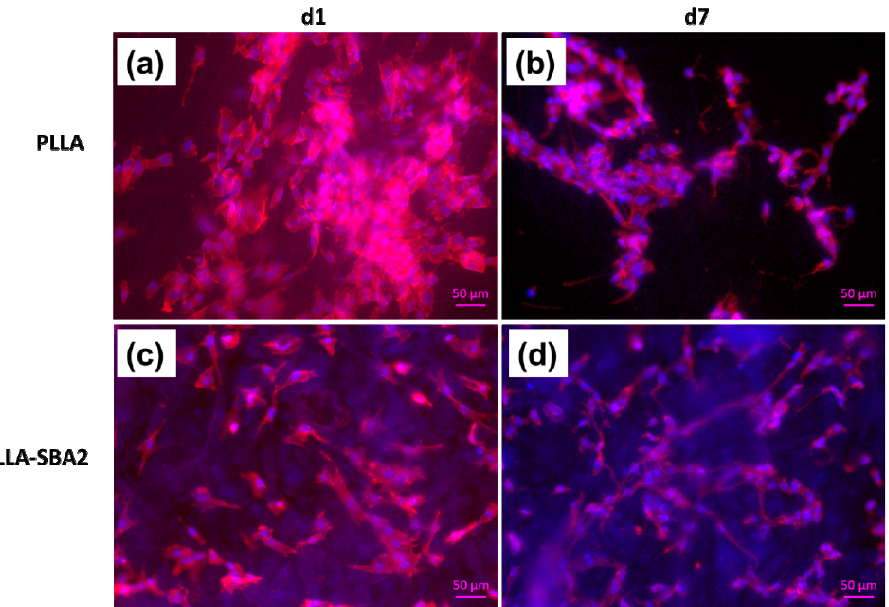
Figure 9. Fluorescent labelled actin filaments (red) and nuclei (blue) in ST2 cells cultured on neat PLLA ( a , b ) and PLLA-SBA2 ( c , d ) fibres, after 1 day ( a , c ) and 7 days from cell seeding. Scale bar: 50 µm.